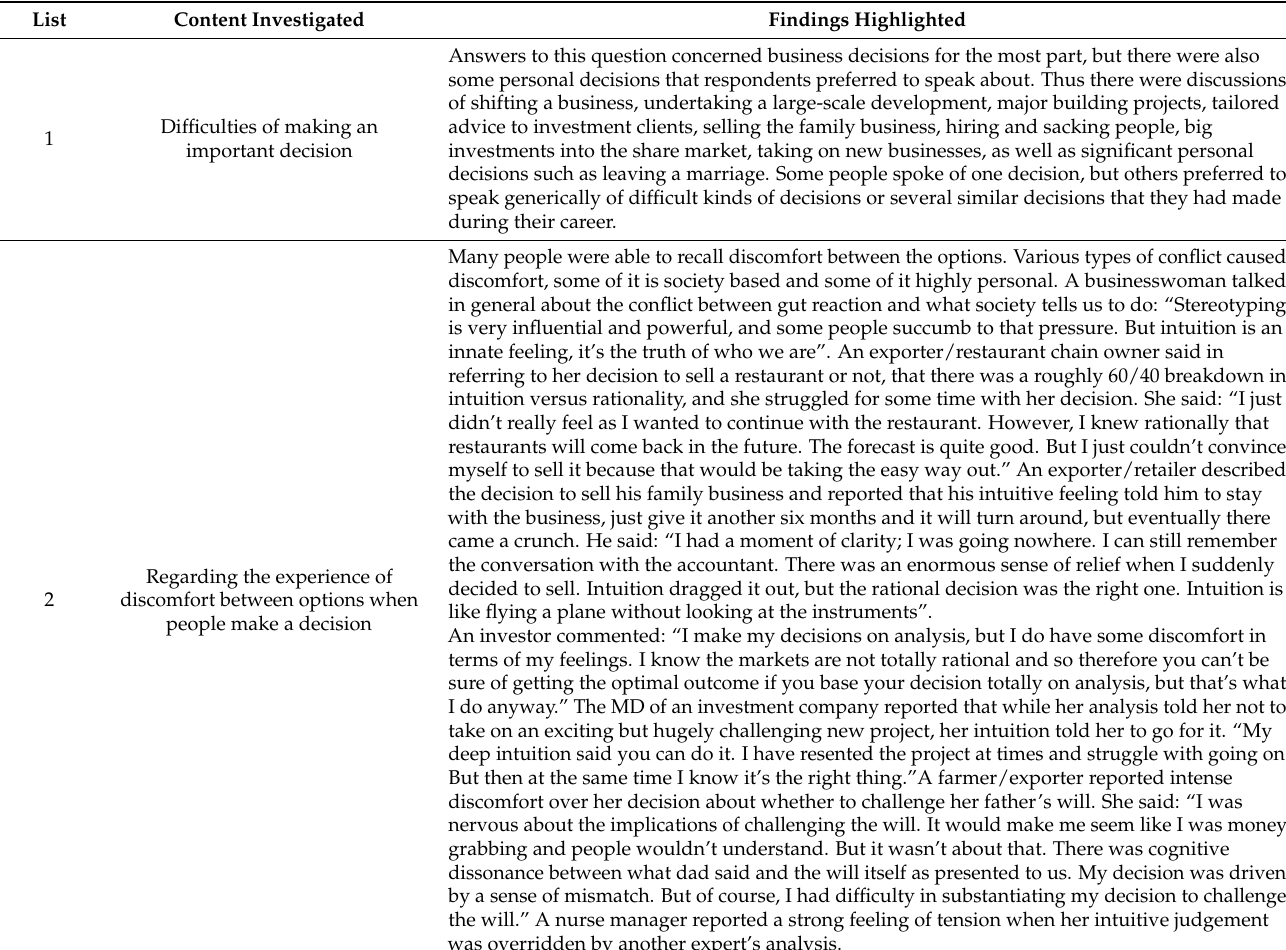
Table 2. Interview findings and